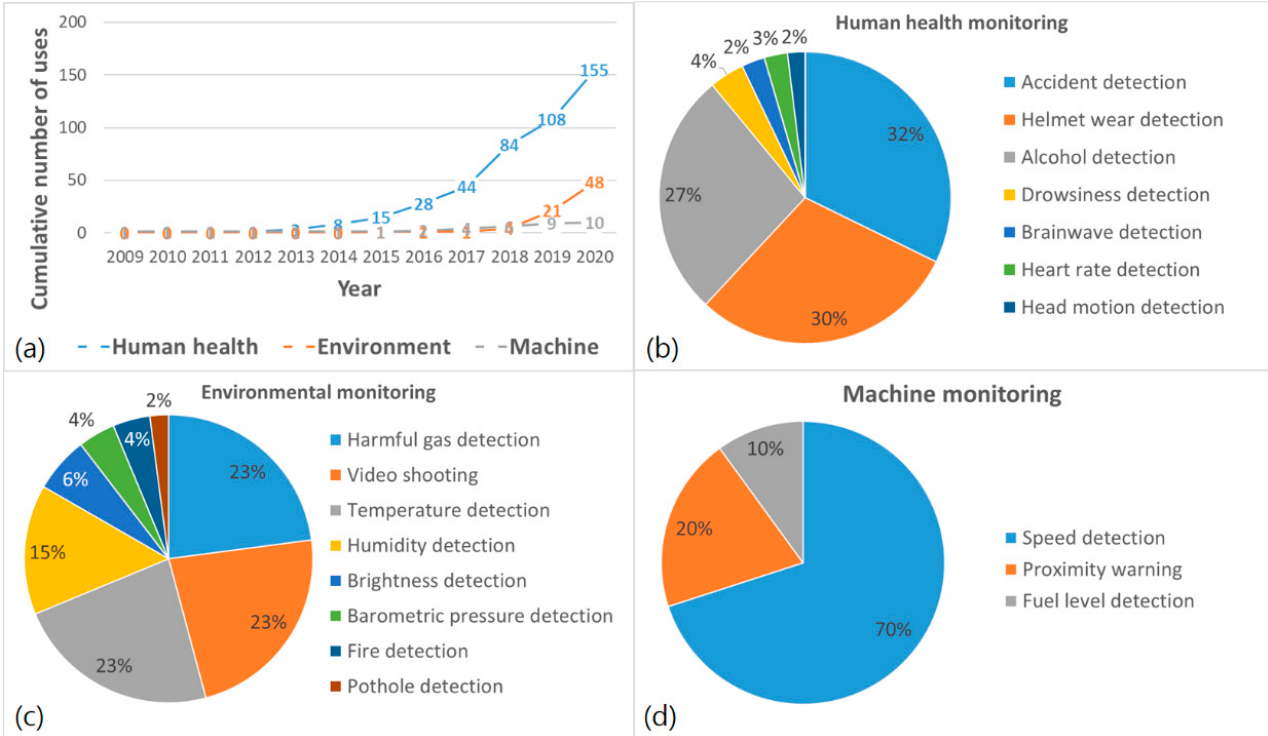
Figure 7. Trend of sensor uses in smart helmet studies. ( a ) Cumulative number of uses of sensor types according to year. Usage percentage of sensors for ( b ) human health monitoring, ( c ) environmental monitoring, and ( d ) machine monitoring.